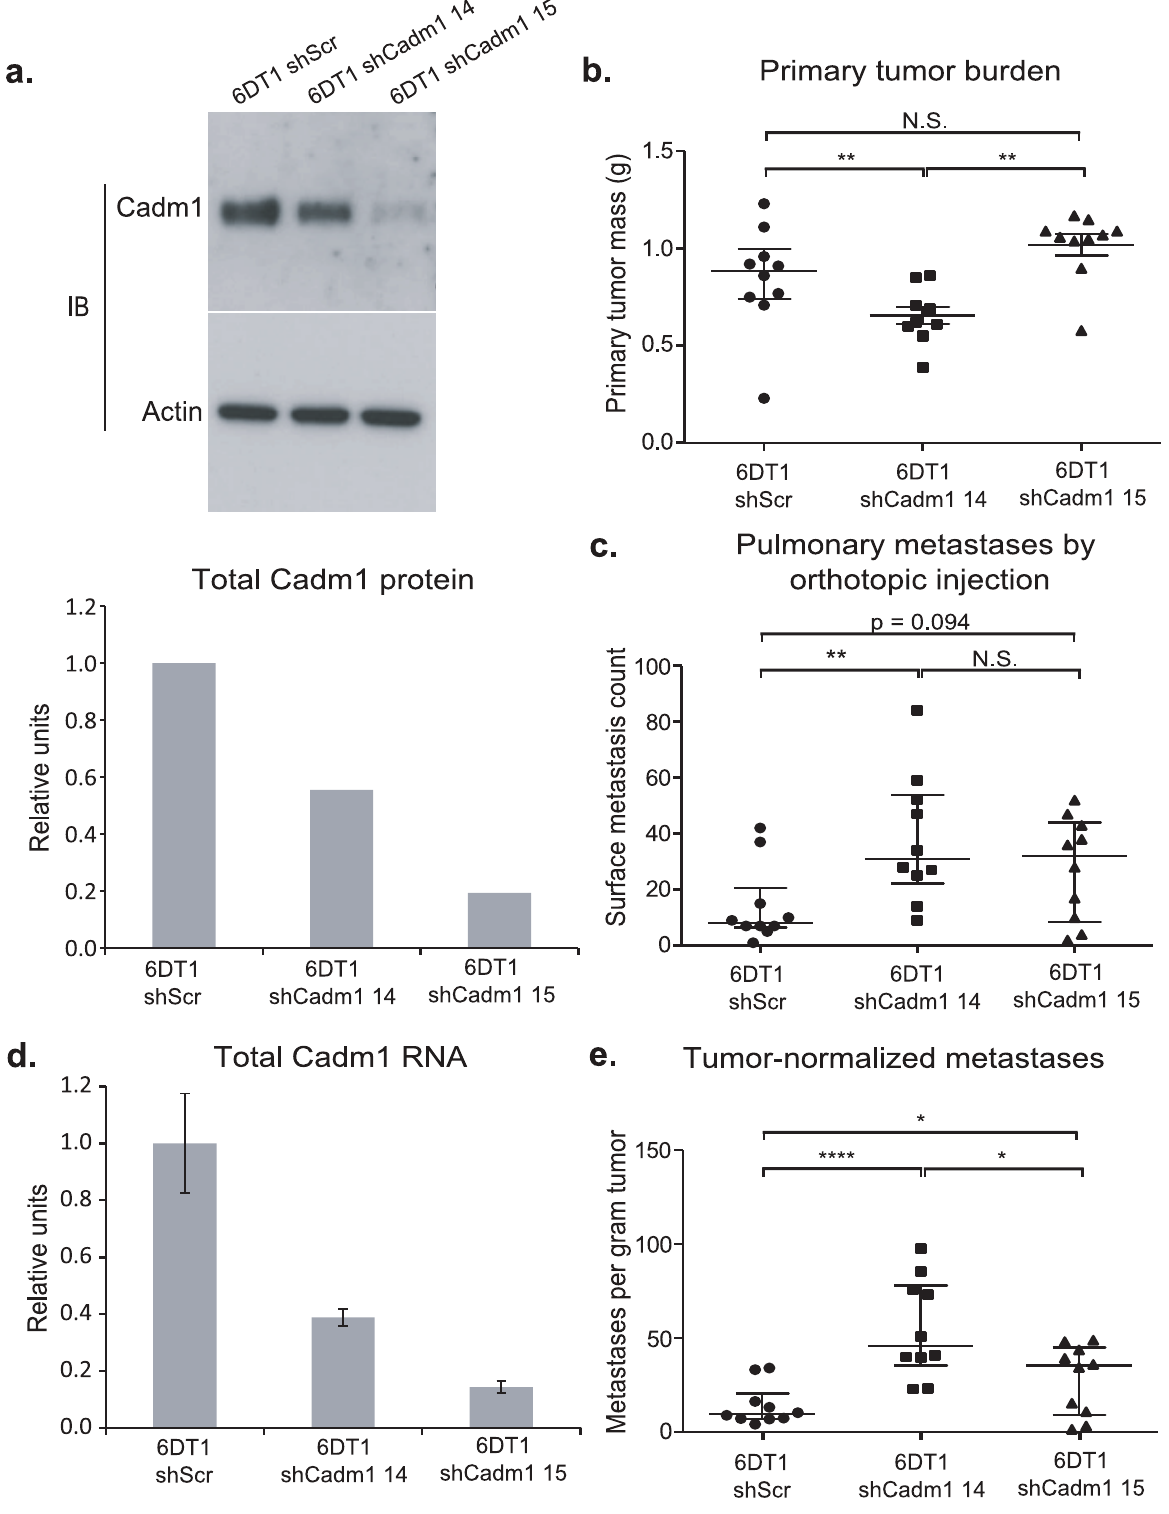
Figure 3. The effect of Cadm1 knockdown on tumor growth and metastasis invivo . 6DT1 cells expressing shRNA constructs targeting Cadm1 showed (a) protein level knockdown of Cadm1 by immunoblot and ECL densitometry quantification and (d) total RNA level knockdown (mean + / 2 SEM). Orthotopic implant data showing the effects of Cadm1 knockdown on primary tumor burden (shScr vs. sh14: p=0.0090; shScr vs. sh15: p=0.0943; sh14 vs. sh15: p=0.0001) (b), pulmonary surface metastases (shScr vs. sh14: p=0.0085; shScr vs. sh15: p=0.0709; sh14 vs. sh15: p=0.3485) (c), and tumor-normalized metastases (e) ((shScr vs. sh14: p=0.00005; shScr vs. sh15: p=0.0444; sh14 vs. sh15: p=0.0152; median + / 2 interquartile range; n=10 mice per group).